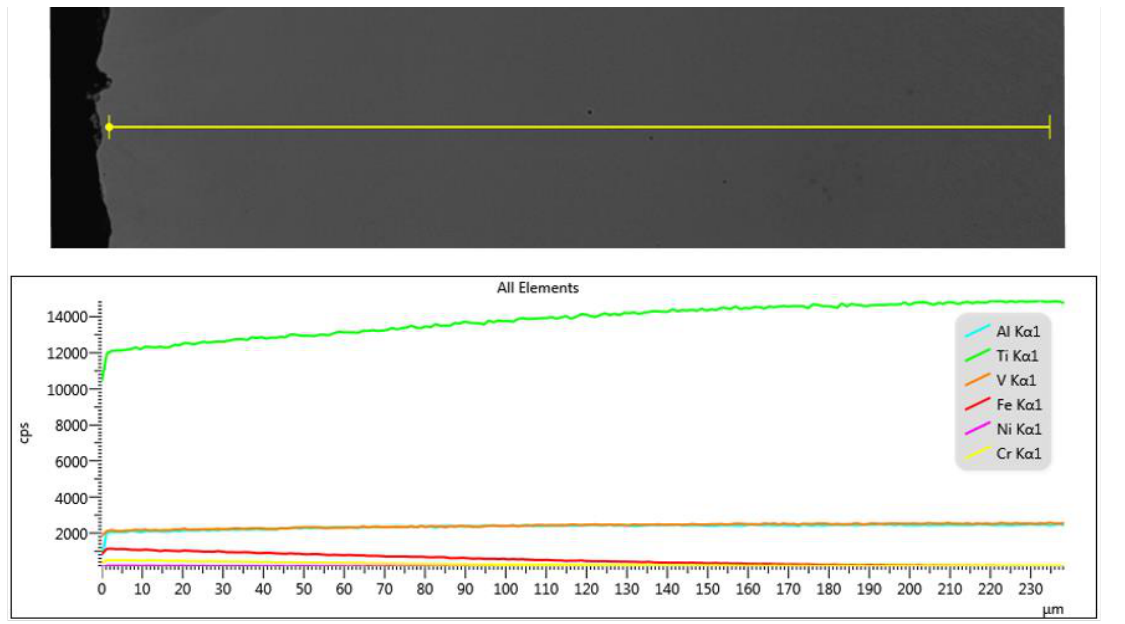
Figure 6. EDS linescan of the contamination at the Ti-6Al-4V DPF femoral stem surface.